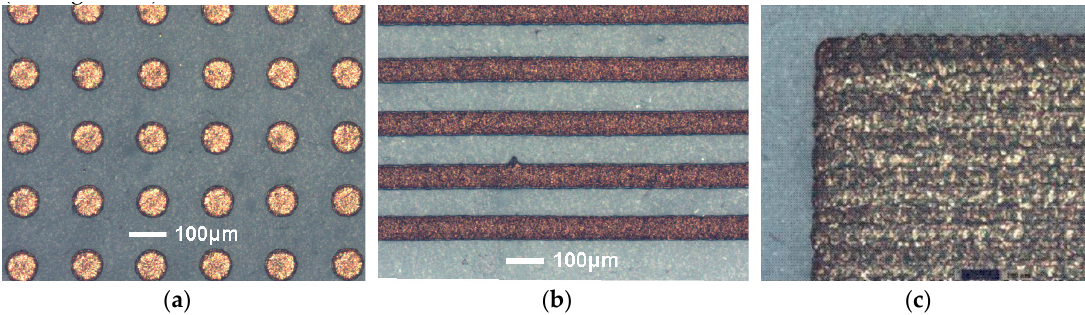
Figure 2. Optical images of the printed ( a ) dot arrays, ( b ) lines at 65 µm print pitch and ( c ) pads on photo paper with a nozzle diameter 50 µm.